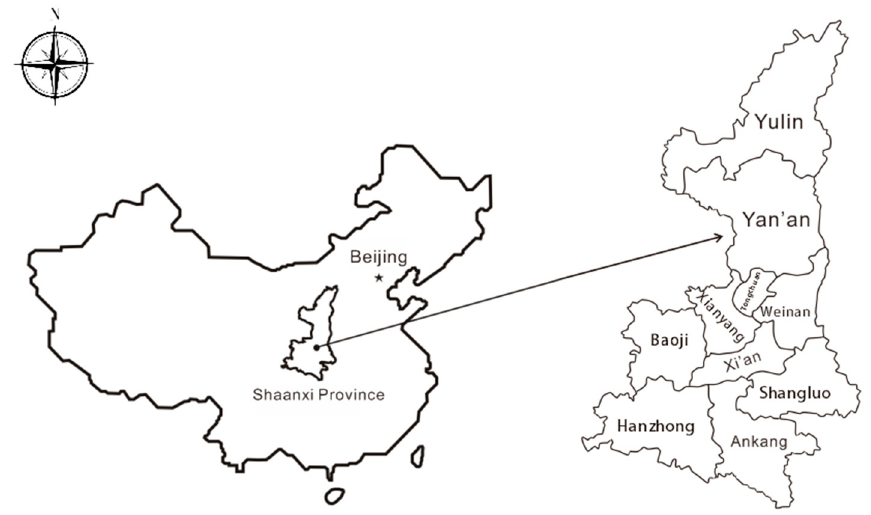
Figure 1. Location of the study site in Shanxi, eastern Loess Plateau, China.